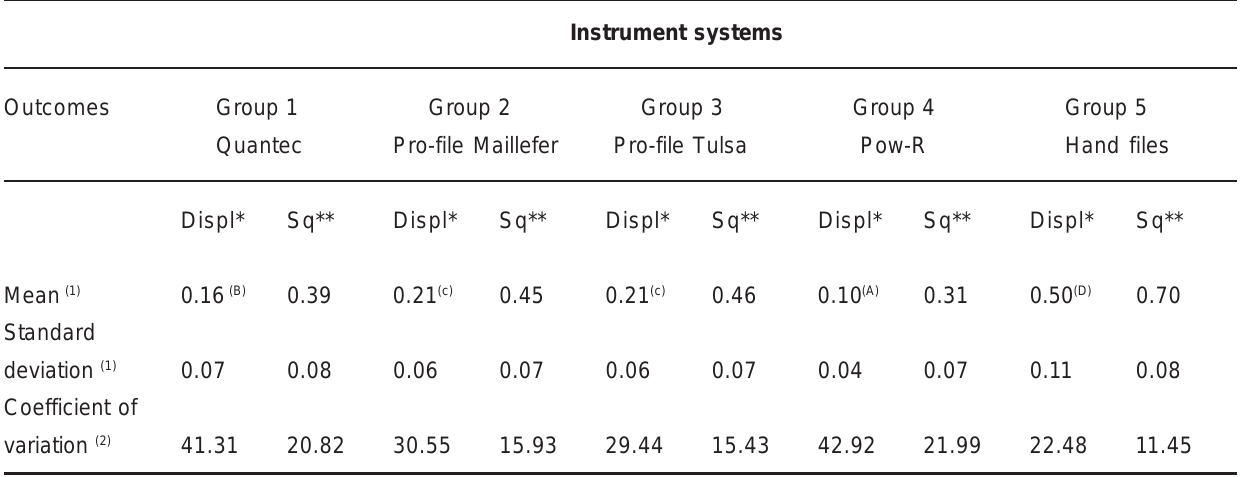
TABLE 1 - Group mean and standard deviation apical displacement values (mm), and the coefficient of variation of the displacement (%), according to the instrument system